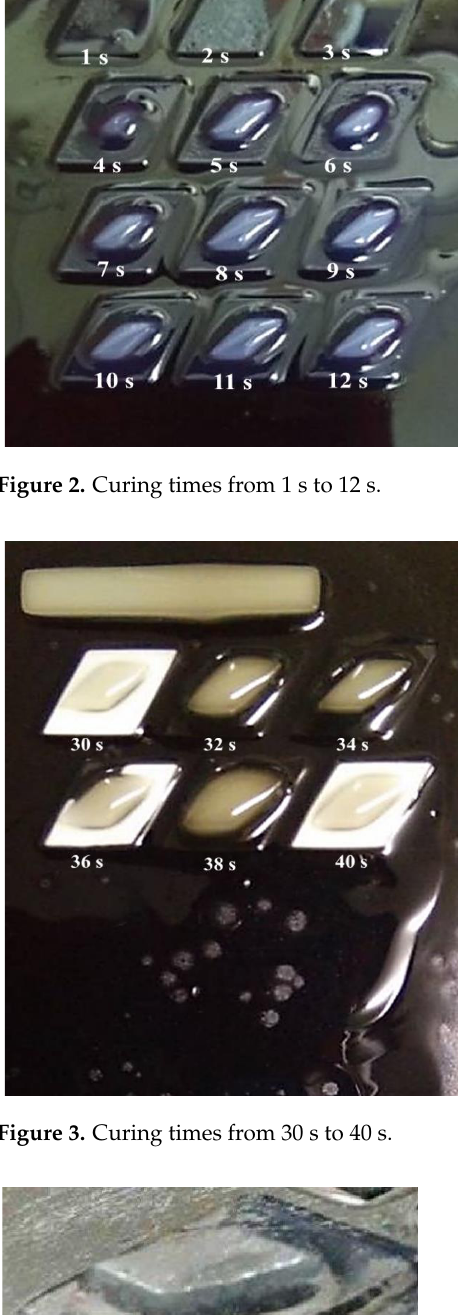
Figure 2. Curing times from 1 s to 12 s.